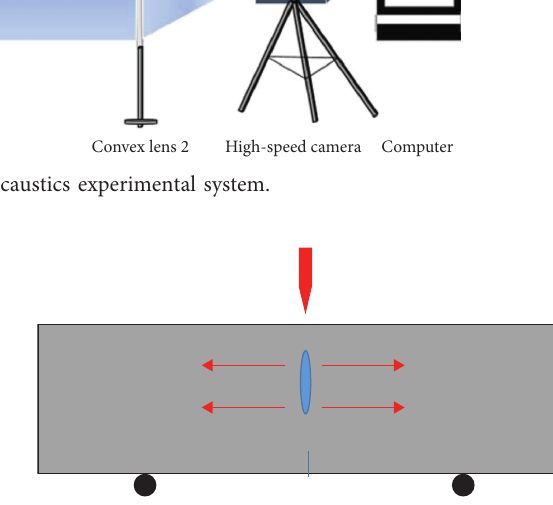
Figure 2: Schematic of the stress on the three-point bending el- liptical crack type I